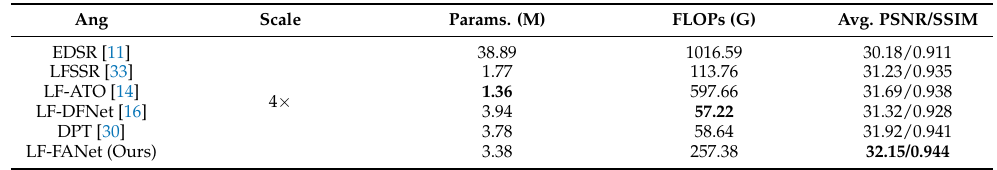
Figure 10. Visualization of a spatially-varying distance map between 4 × SR image and ground-truth map. Table 3. Comparative results in terms of the number of parameters, FLOPs, and average PSNR/SSIM on testing sets for 4 × LF image SR methods. The best results are in